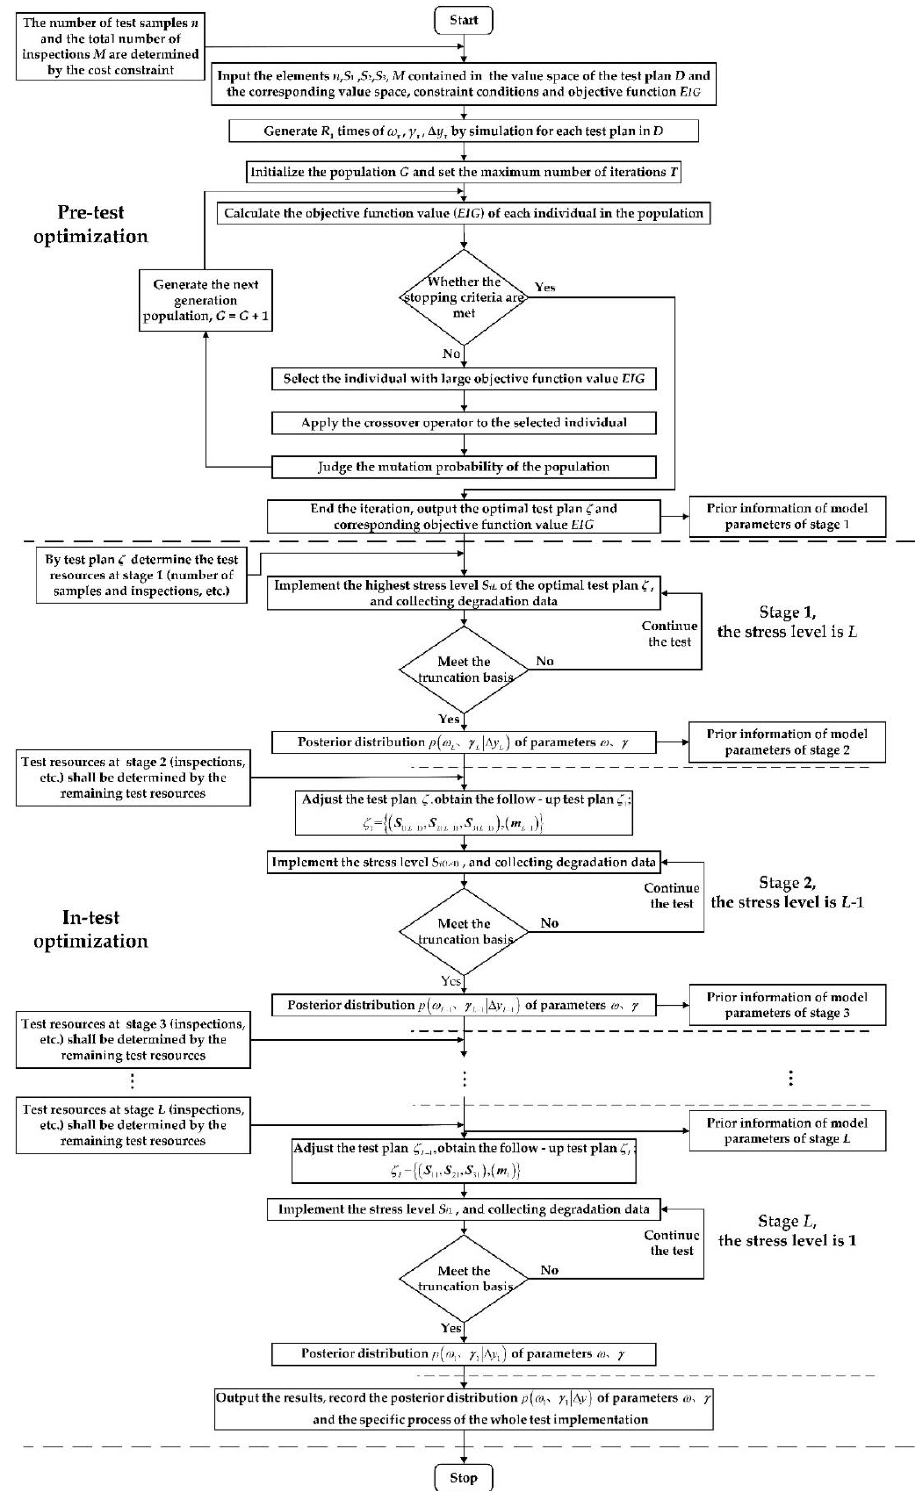
Figure 4. Optimization process of three-stress ADT plan of motorized spindle with poor prior